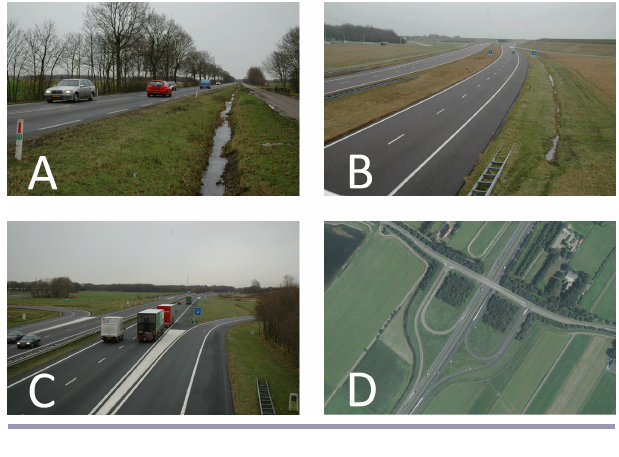
Fig. 3 . Examples of road design in Friesland: (A) minor road, (B) major road with broad verge, (C) junction between a major and minor road, and (D) the same junction as in C, but from aerial view (Google Earth).